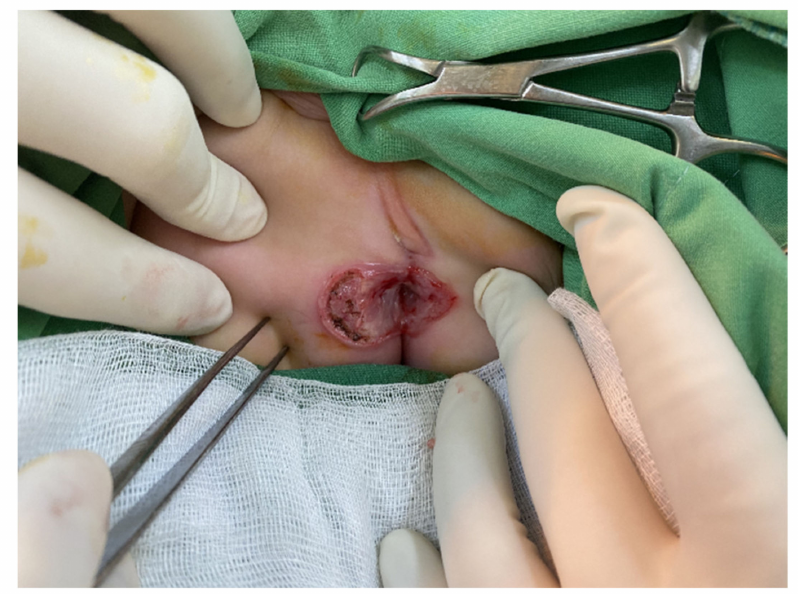
Figure 2. Polypoid granulation tissue was noted on the right buttock, 9 o’clock, with a skin defect. The pathology of that granulation tissue revealed acute suppurative inflammation and necrotic tissue. However, the wound did not heal even after two more months of wound care. Therefore, we let the wound heal by itself, and the anus turned into an acquired imperforate anus spontaneously 5 months after the first debridement (Figure 3).